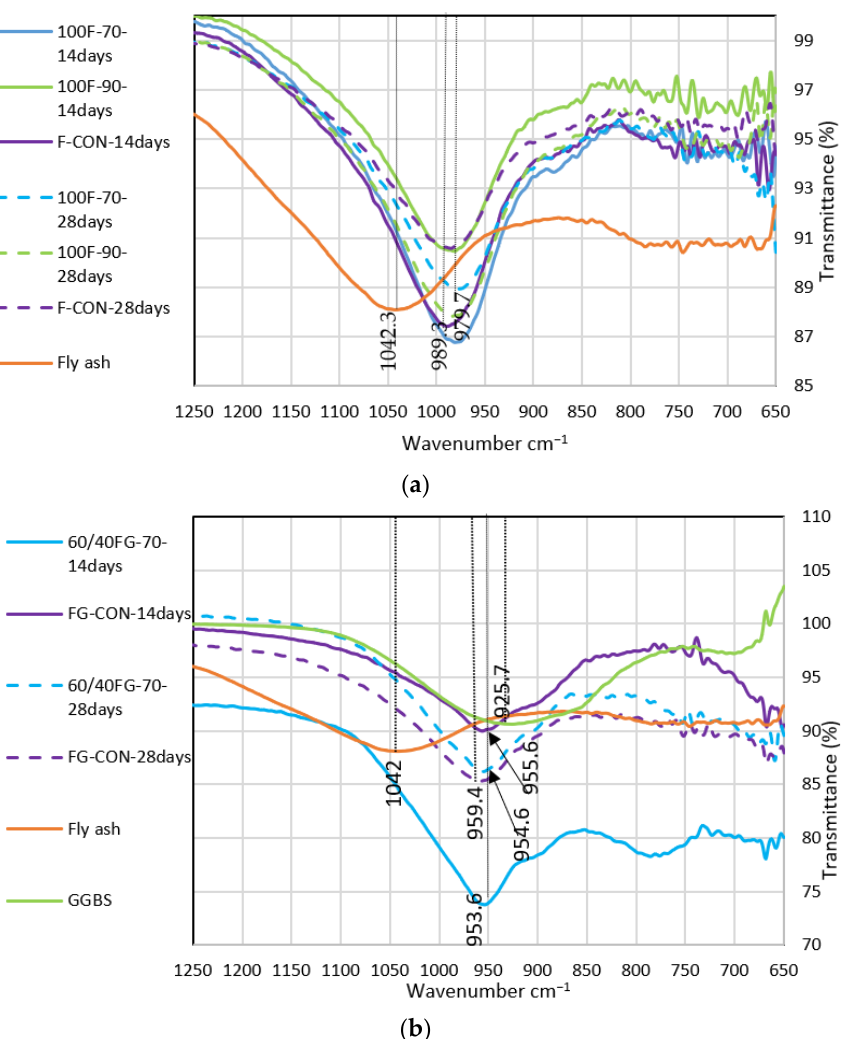
Figure 2. ( a ) FTIR of neat fly ash pastes activated with WG-based and commercially available activators at 14 and 28 days. Detail of the range 1250 – 650 cm − 1 . ( b ) FTIR of 60/40 fly ash/slag paste activated with WG-based and commercially available activators at 14 and 28 days. Detail in the range 1250 – 650 cm − 1 .